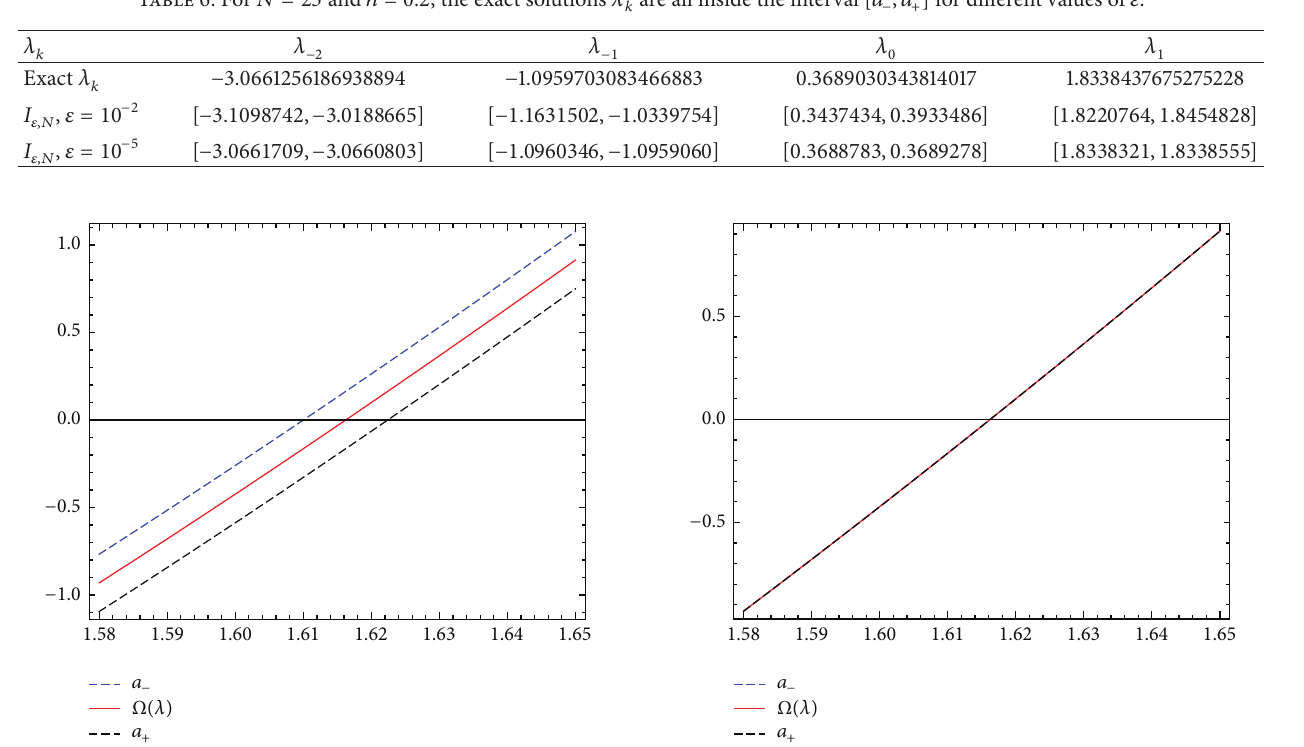
Table 6: For 𝑁 = 25 and ℎ = 0.2 , the exact solutions 𝜆 𝑘 are all inside the interval [𝑎 − ,𝑎 + ] for different values of 𝜀 .